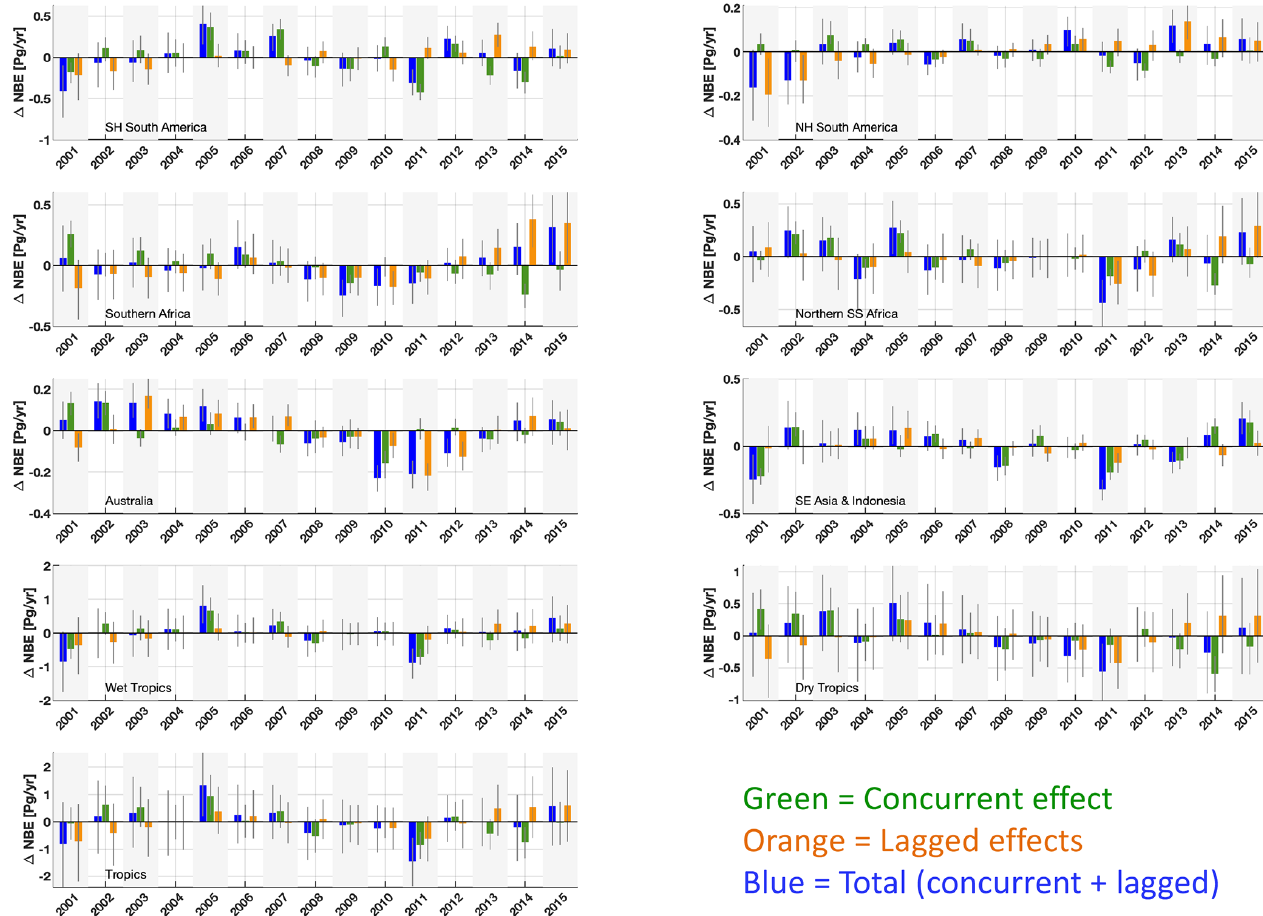
Figure 6. Regional and pan-tropical median annual (cid:49) NBE (blue bars) and its attribution to concurrent effects ( (cid:49) NBE CON , green bars) and lagged effect ( (cid:49) NBE LAG , orange bars) components. The geographical definitions for each region are shown in Fig. A1. Error bars denote the 25th–75th percentile uncertainty estimates for each flux